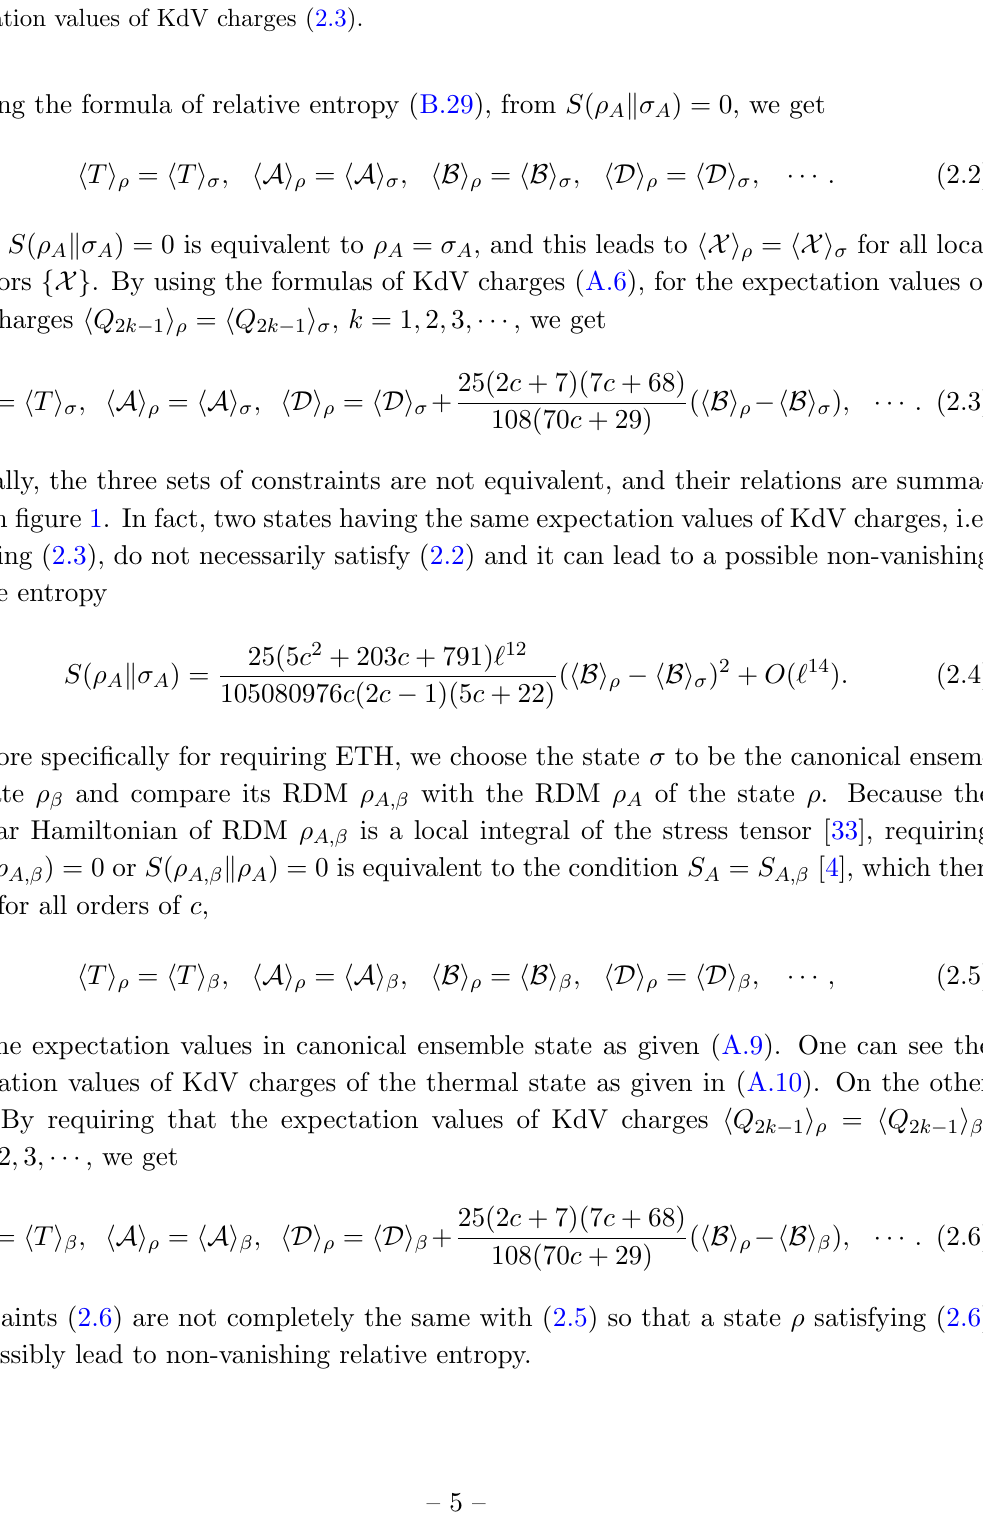
Figure 1 . Relations of the three sets of constraints from the EE (2.1), relative entropy (2.2) and expectation values of KdV charges